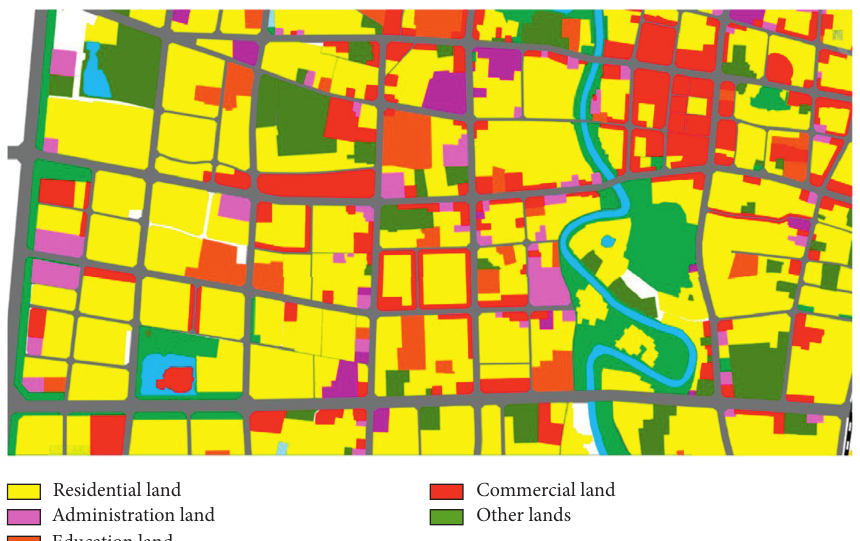
Figure 4: Schematic of land use types in the central area of